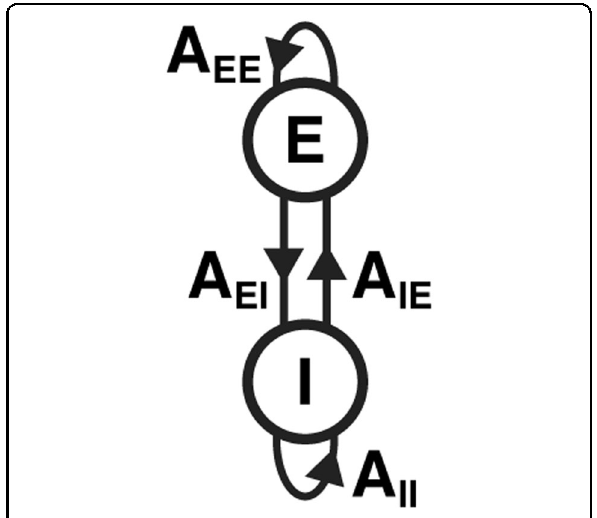
Fig. 5 Excitatory/inhibitory coupling. An excitatory (E) and inhibitory (I) region, with E-to-E coupling ( A EE ), E-to-I coupling ( A EI ), I- to-E coupling ( A IE ) and I-to-I coupling ( A II